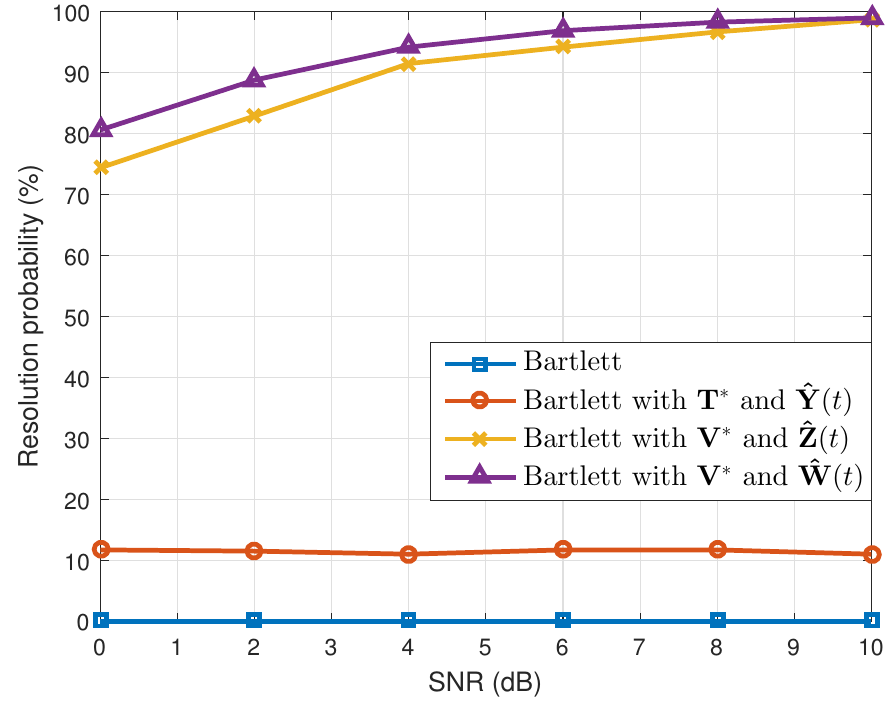
Figure 10. Resolution probabilities versus SNR ( N = 5).